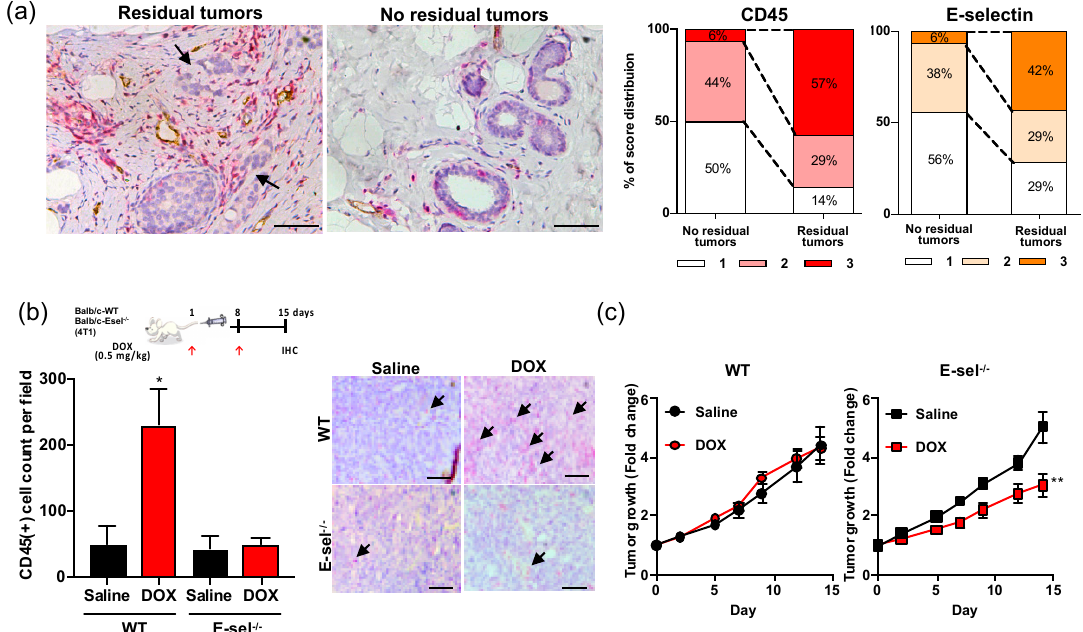
Figure 1. High CD45 + density in DOX-treated breast tumors. ( a ) CD45 + immune cells and E-selectin +